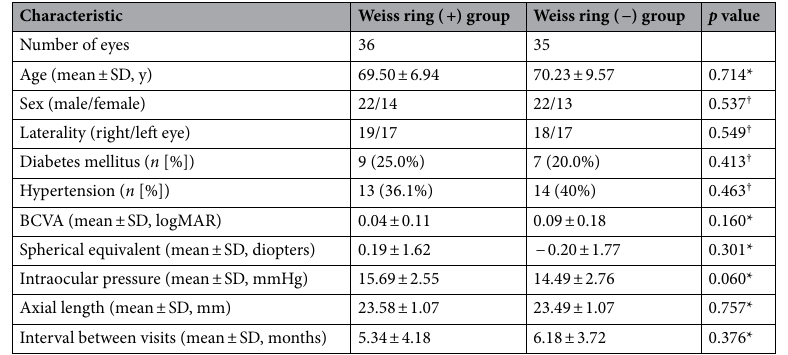
Table 1. Baseline characteristics of the participants. *Comparison between groups 1 and 2 using the independent t -test. † Comparison between groups 1 and 2 using the chi-square test. SD standard deviation, BCVA best-corrected visual acuity, logMAR logarithm of the minimum angle of resolution.